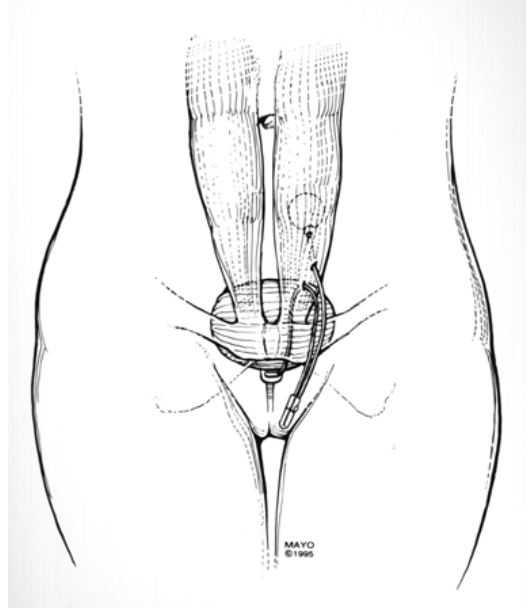
FIGURE 10. Location of components of the female AUS.